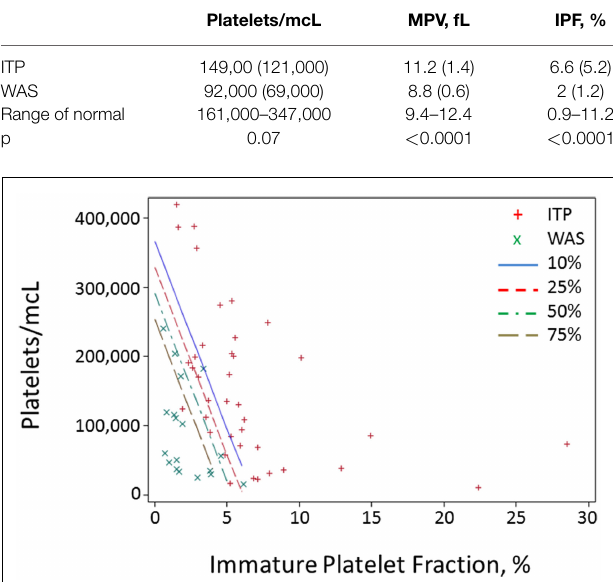
TABLE 3 | Means (SDs) of platelet parameters from the first-blood-draw data set for the derivation cohort .